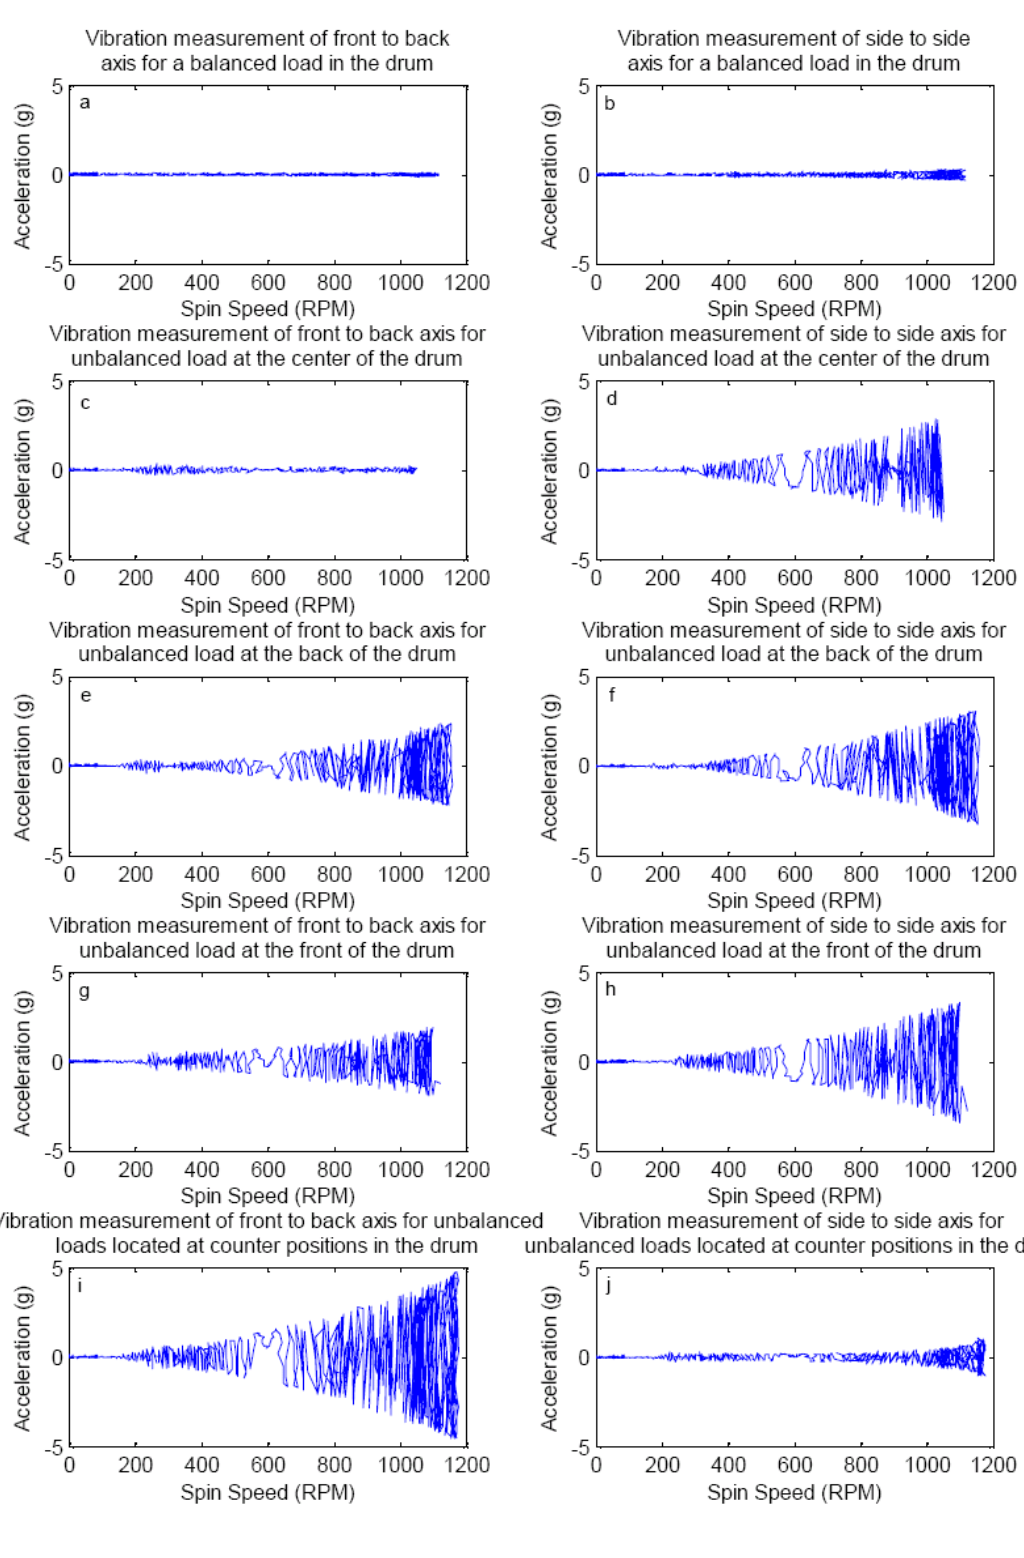
Figure 2. Acceleration measurements of fixed unbalance at some different locations in the